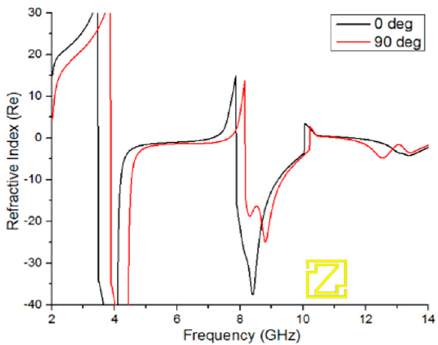
Figure 6. Real magnitude of the refractive index ( η ) vs. the frequency of the 0-degree and 90-degree rotated unit cell.